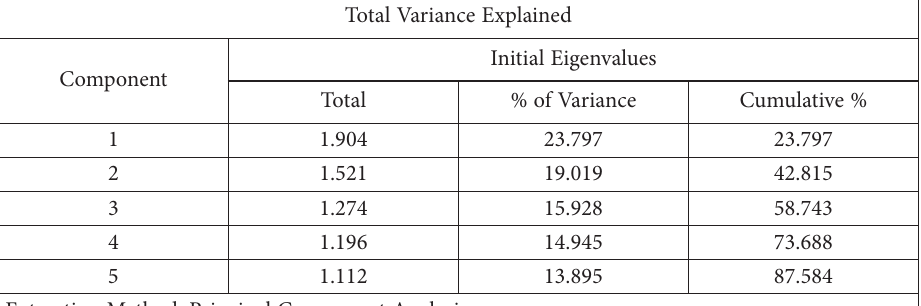
Table 4. Components analysis – model summary